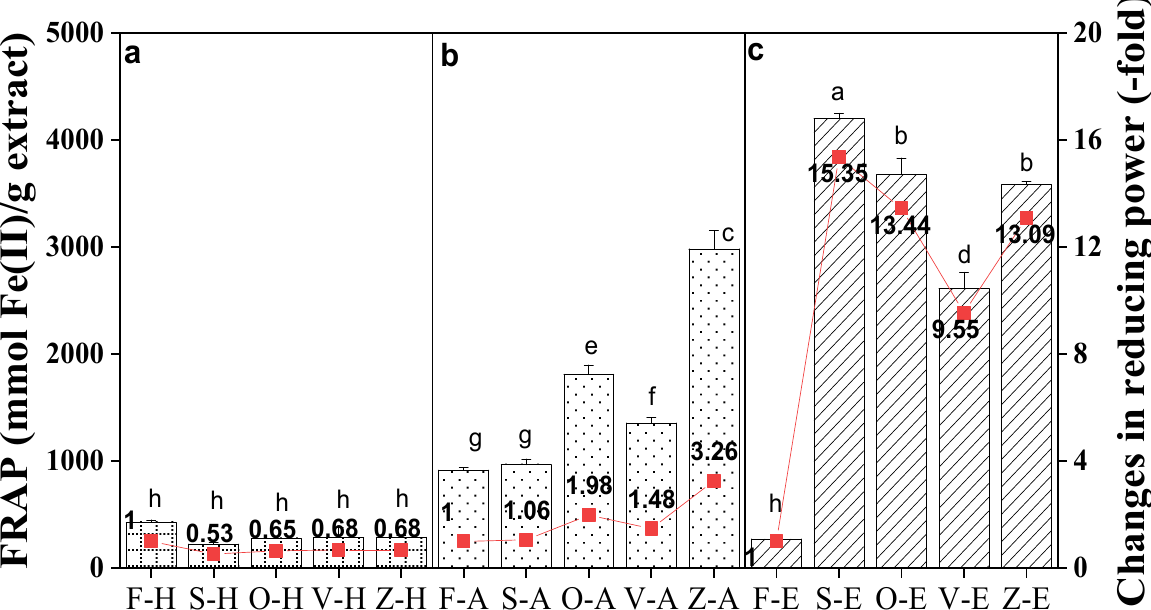
Figure 2. Reducing power of Bentong ginger extracted using ( a ) hot water (H), ( b ) aqueous (A), and ( c ) ethanol (E) solvents via sun (S)-, oven (O)-, vacuum (V)- and freeze (Z)-drying methods. Fresh ginger (F) was used as the control. Changes were calculated based on the respective fresh ginger samples. Bars with different letters are significantly different. Sample F-H = Fresh ginger (Control) with hot water, and sample Z-E is freeze-drying with ethanol.